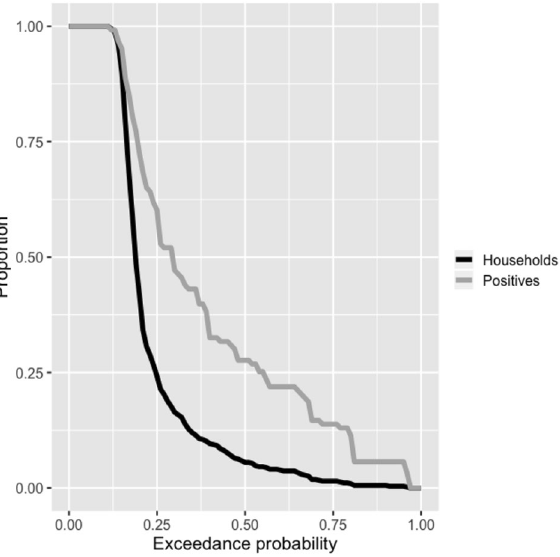
Figure 4. Proportion of houses sampled (black line) and proportion of positive individuals identified (grey line) if predicted high risk locations are sampled based on varying levels of exceedance probability used to define predicted high risk (for a 5% predicted prevalence